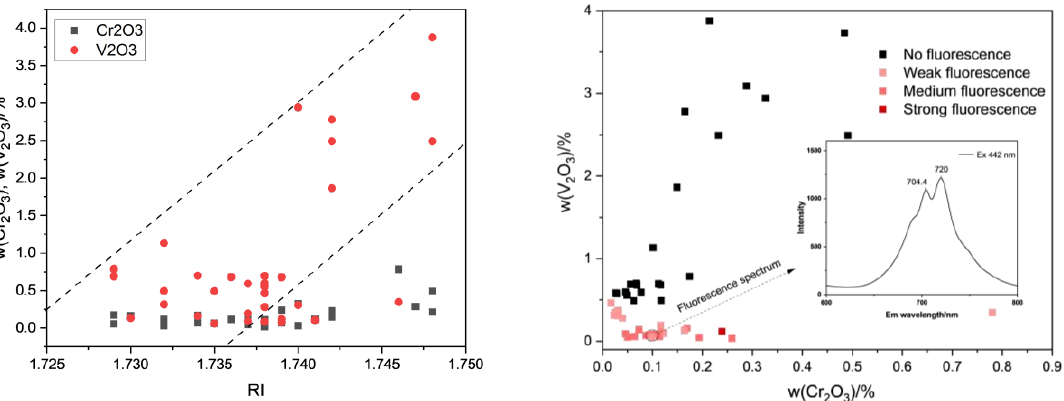
Figure 2. Left: Variation between refractive index and w(Cr 2 O 3 )and w(V 2 O 3 ): RI showing an increas- ing trend when the w(V 2 O 3 ) increases. Right: Relationship between fluorescence with w(Cr 2 O 3 )and w(V 2 O 3 ).